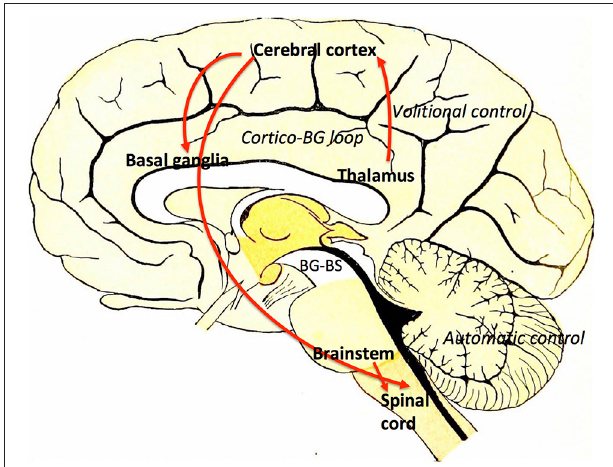
FIGURE 3 | Volitional and automatic control of locomotor movements by the BG-BS system: GABAergic BG output to thalamocortical and brainstem neurons assimilates volitional and automatic movement control processes. Adapted from Villiger and Piersol